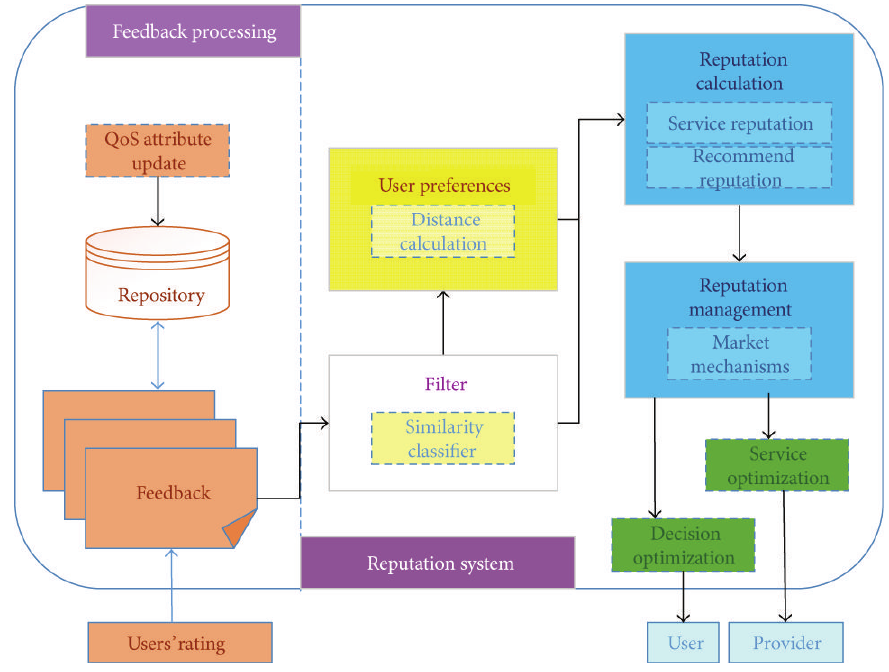
Figure 2: Reputation system